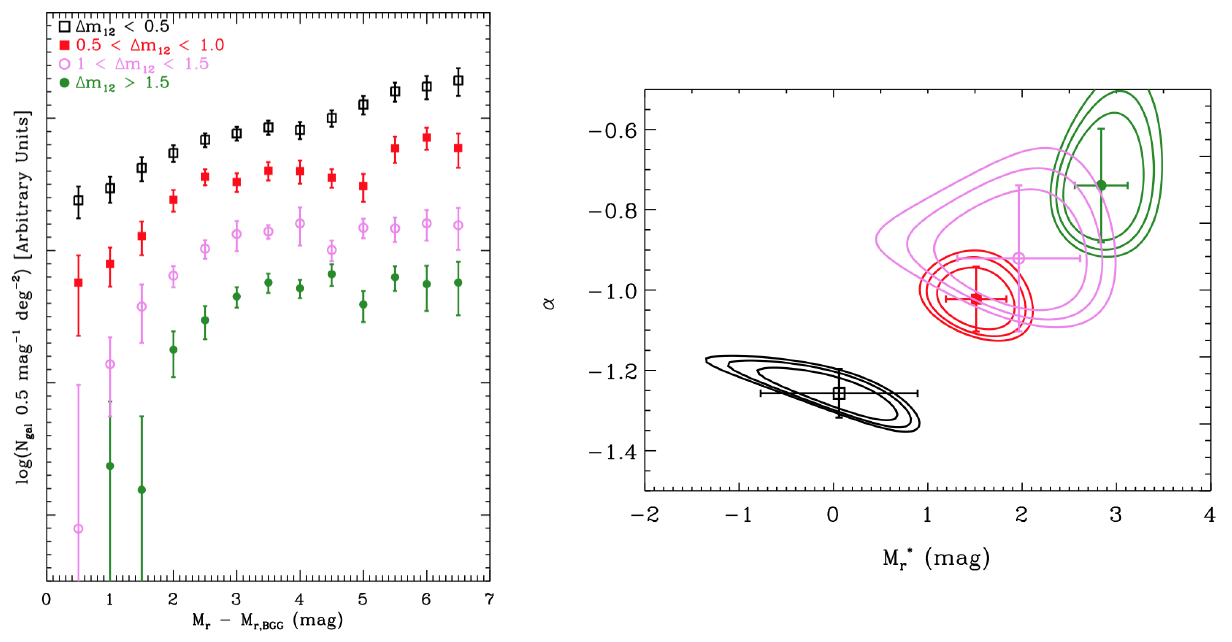
Figure 7. Left panel : relative LFs for the four subsamples presented in Zarattini et al. [111]. Empty black squares are systems with ∆ m 12 < 0.5, filled red circles are systems with 0.5 < ∆ m 12 < 1.0, empty violet circles are systems with 1.0 < ∆ m 12 < 1.5, and filled green circles are systems with ∆ m 12 > 1.5. Right panel : Uncertainty contours for the Schechter fits of LFs in the left panel. Contours represent 68%, 95%, and 99% c.l. and the colour and symbol codes are the same as in left panel. The original image can be found in Zarattini et al. [111]; in particular, the left panel corresponds to their Figure 7, the right panel to Figure